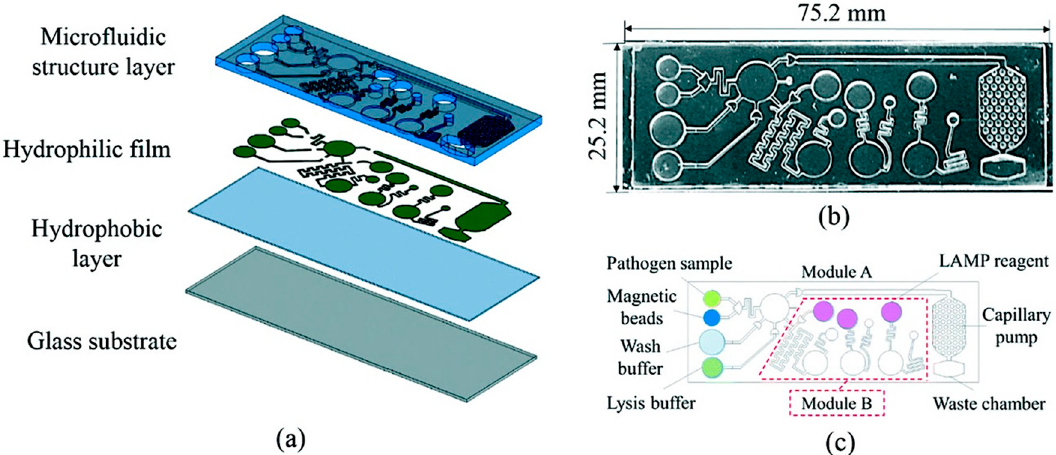
Figure 23. (a) Exploded view of the self-driven microfluidic chip consisting of a polydimethylsiloxane (PDMS) microfluidic structure layer, a hydrophilic film, a PDMS hydrophobic layer, and a glass substrate. (b) A photograph of the chip. (c) Schematic illustration of the chip design. The area enclosed by the red dotted line represents the LAMP reaction module (module B), with the other area being used for sample treatment (module A). (Re-printed from Ma et al. [159]. Copyright (2019), with permission from The Royal Society of Chemistry).